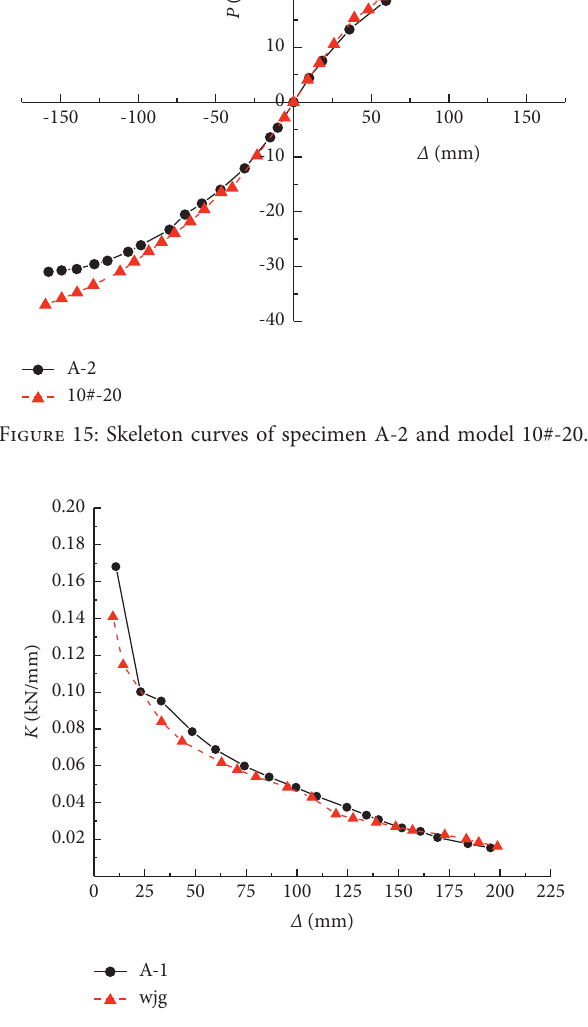
Figure 16: Stiffness degradation curves between specimen A-1 and model